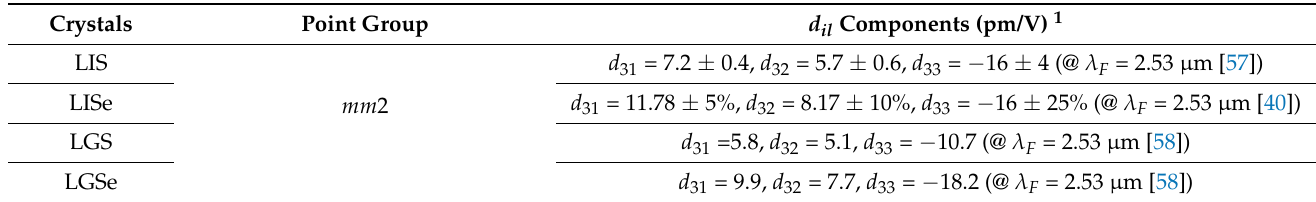
Table 5. The d il components of orthorhombic ternary chalcogenides considered in this study. Crystals Point